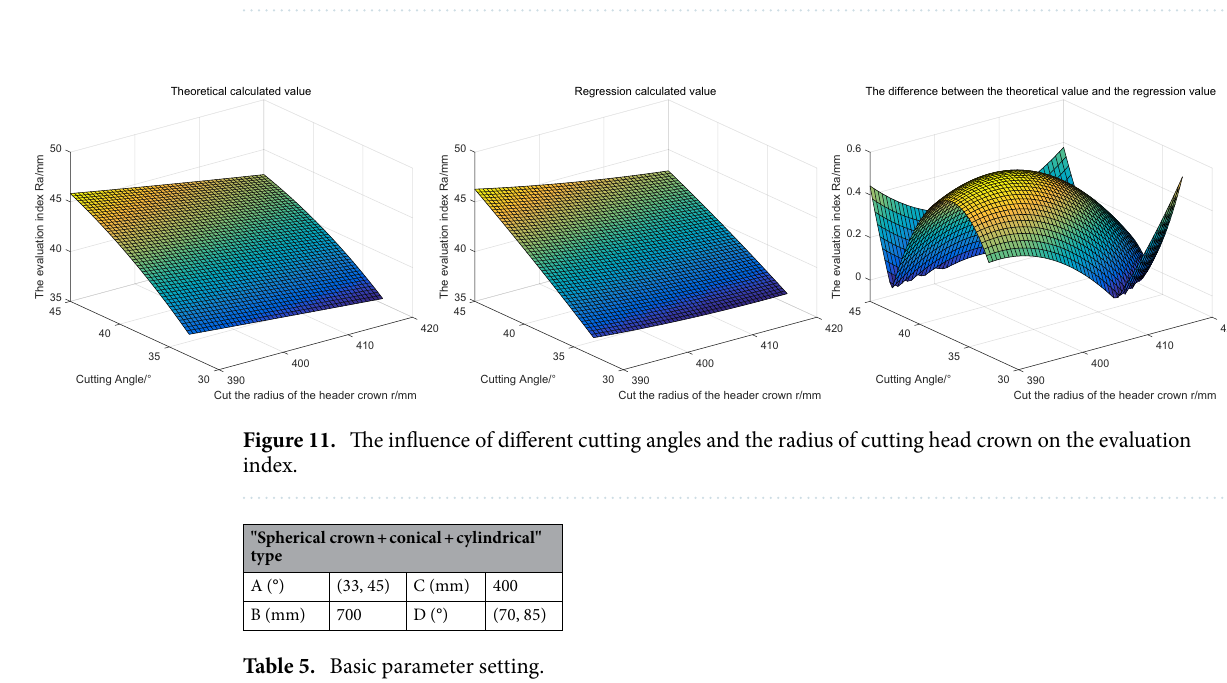
Table 5. Basic parameter setting.